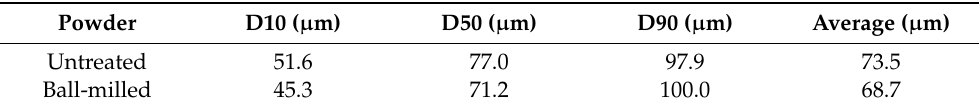
Figure 6. X ‐ ray photoelectron spectroscopy (XPS) survey spectra of Inconel 718 PA powders: ( a ) Virgin powder; ( b ) Ball ‐ milled (30 min) powder.